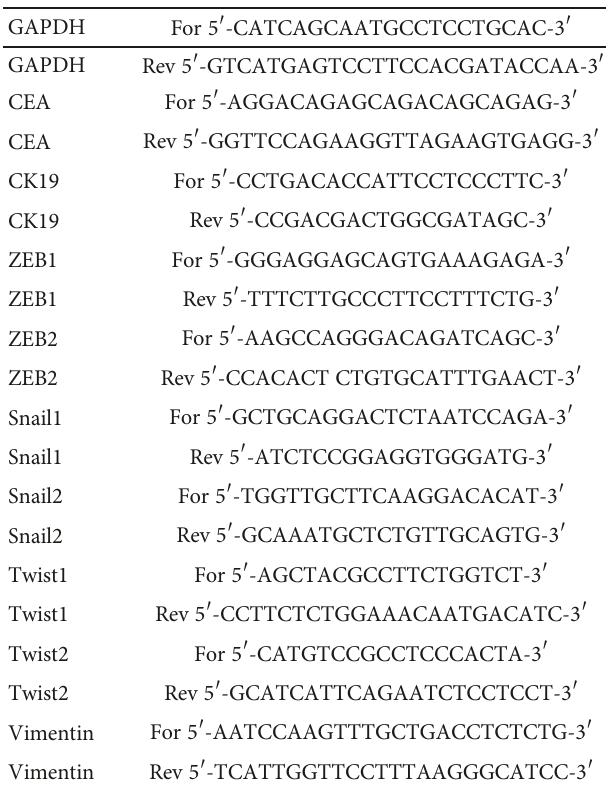
Table 1: Primers used for target and housekeeping genes. GAPDH For 5 ′ -CATCAGCAATGCCTCCTGCAC-3 ′